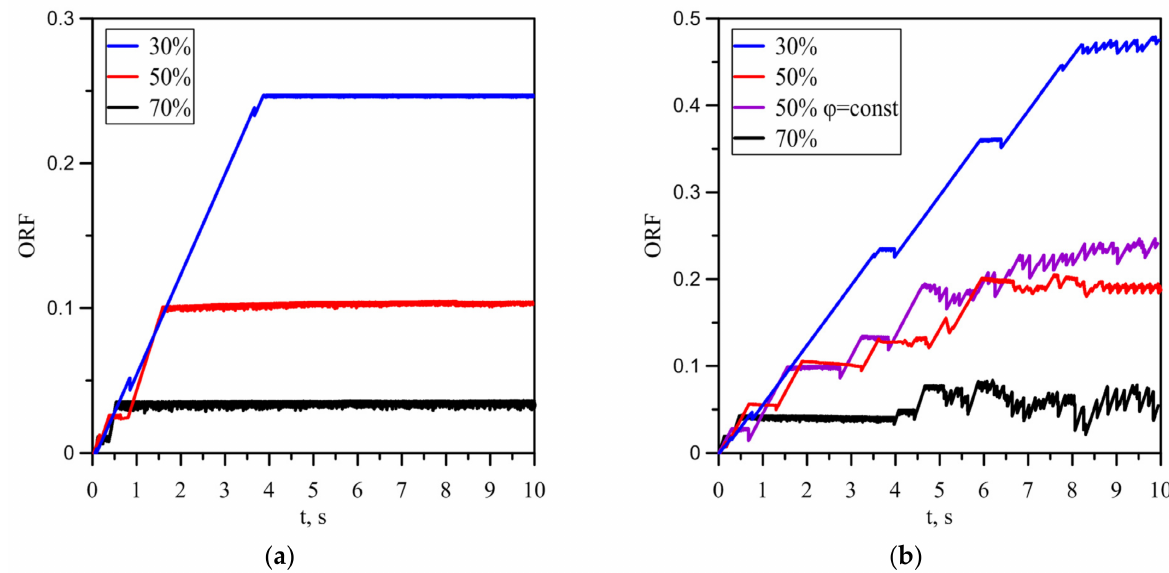
Figure 5. Dependence of the ORF on time during displacement by water ( a ) and 1 wt% SiO 2 ( b ) for different initial water